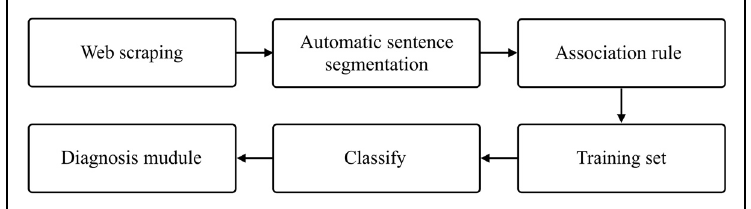
Fig. 1. Research model